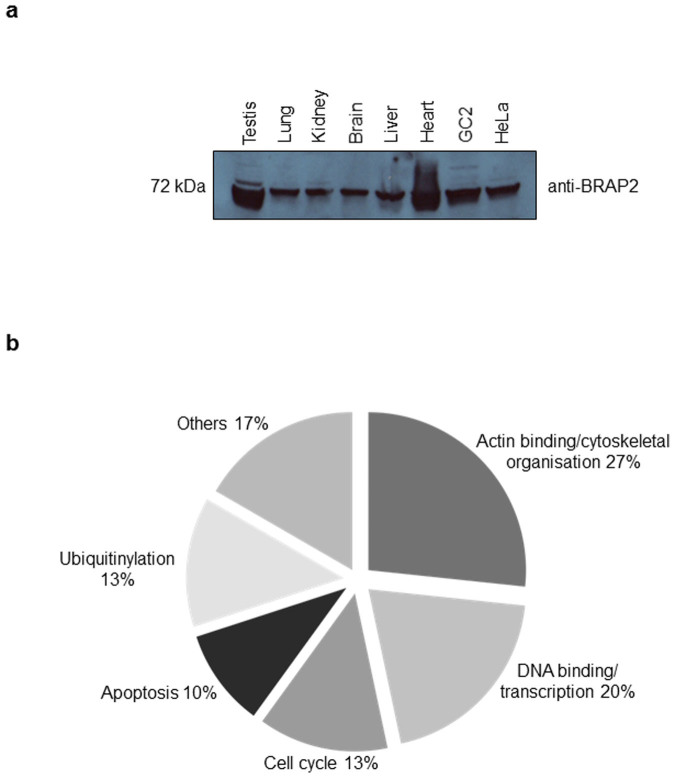
BRAP2 and its binding partners are highly expressed in testis.(a) Western analysis for expression of BRAP2 protein in normal mouse tissues and in HeLa/GC2 cell lines performed as per the methods section. (b) Classification of potential BRAP2 binding proteins identified in Y2H screen according to broad functions as per data mining.